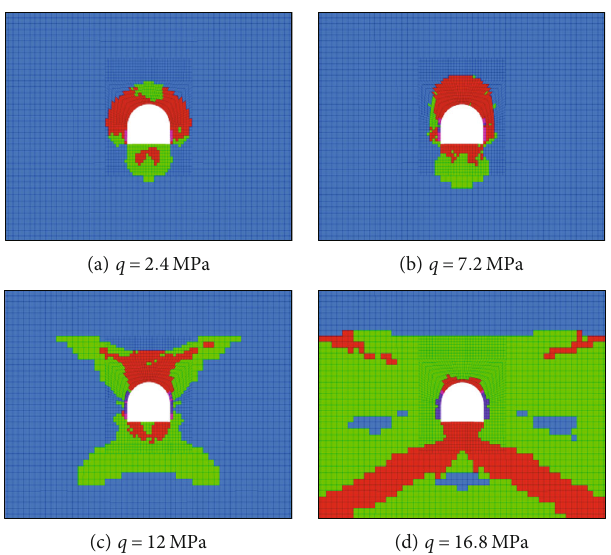
Figure 4: The distribution of plastic zone under various deviatoric stresses. Blue is no damage, red is raw shear failure, and green is shear failure has occurred.